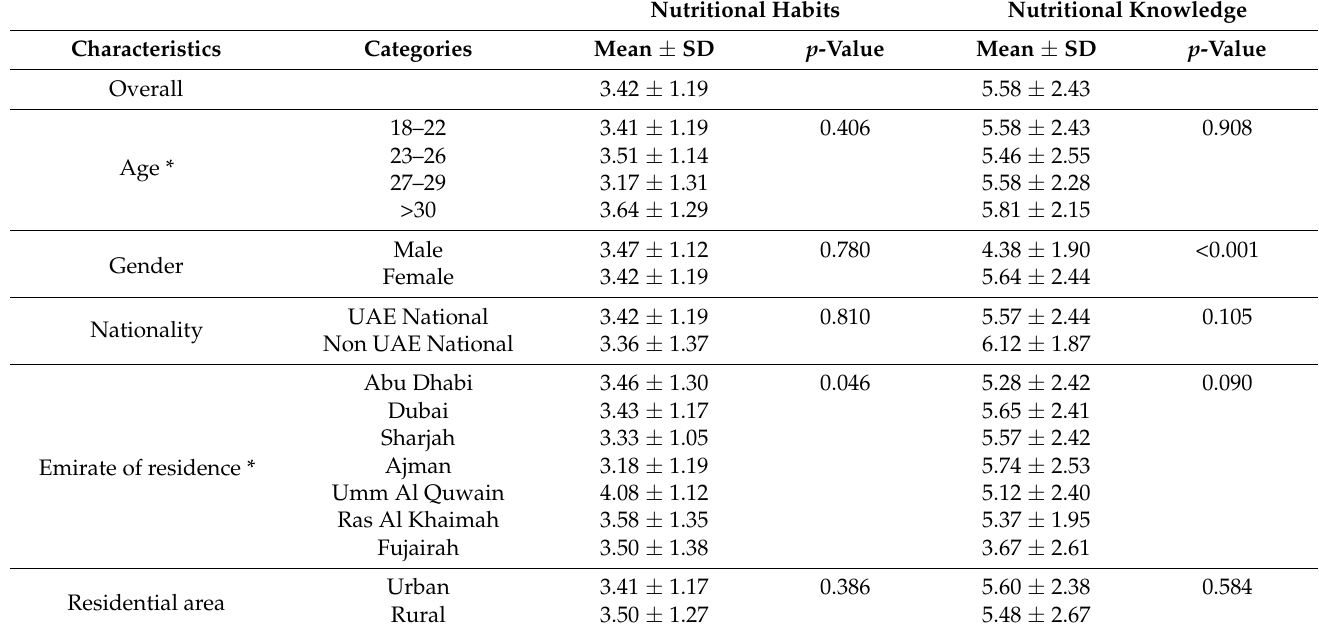
Table 3. Relationship of nutritional knowledge and nutritional habits with socio-demographic factors (n =